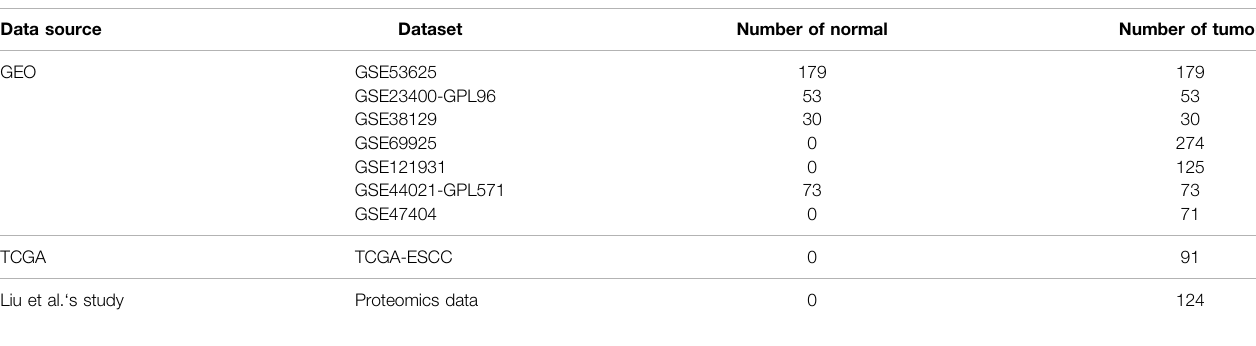
TABLE 1 | Summary of all datasets in this